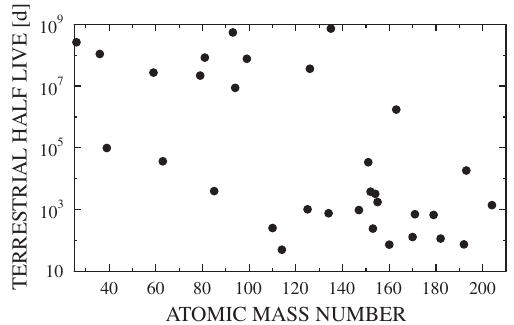
FIG. 3. Terrestrial β − live times for unstable isotopes on the classical s -process path as a function of mass number. Shown are only isotopes where the neutron capture under stellar conditions is faster than the stellar β − decay for a neutron density of 4 × 10 8 cm − 3 at a temperature of 30 keV, the conditions of the classical s process [4]. If the β decay is faster than the neutron capture, the s process proceeds to the next higher element.